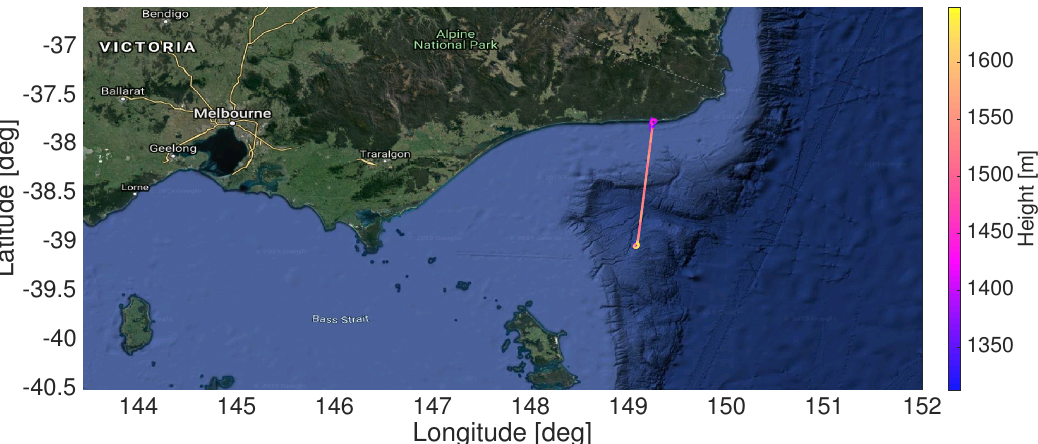
Figure 2. Ground track of sea flight over the Bass Strait. The color scale represents the flight height above the sea